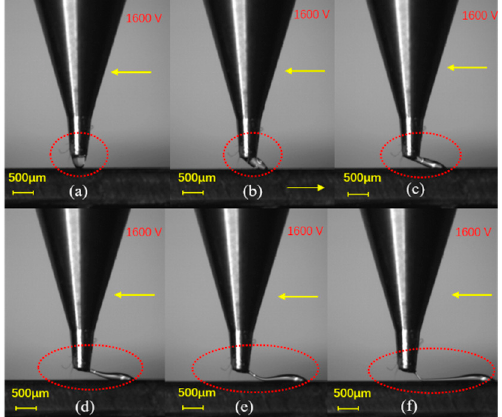
Figure 6. Continuous conical jet formation and horizontal deposition morphology.( a ) a continuous cone jet was generated, ( b – f ) the process of cone jet is further stretched to form fine filaments under viscous dragging force ( F D ).